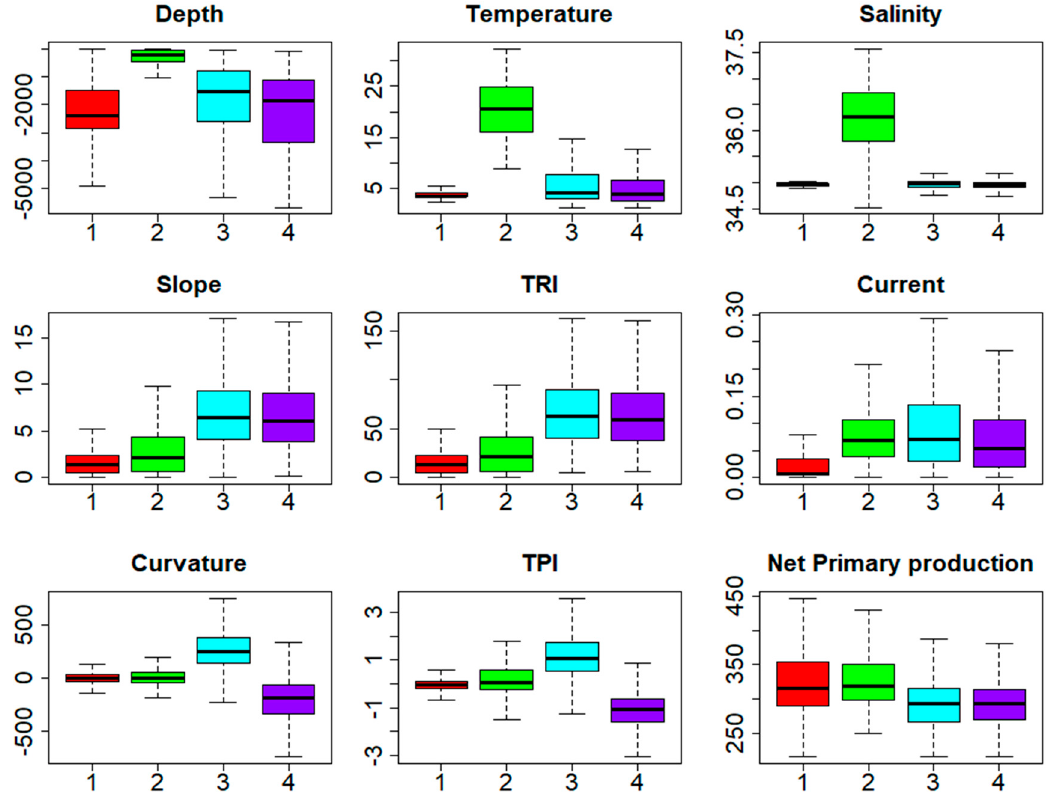
Figure 8. Boxplots of the nine original abiotic variables for each of the K-means derived clusters for the smaller study area using three eigenvalues. The x-axis denotes the five K-means clusters, the y-axis denotes the respective units of each abiotic variable. The colours represent the corresponding cluster in the landscape map (Figure 7). Format of boxplots as described in Figure